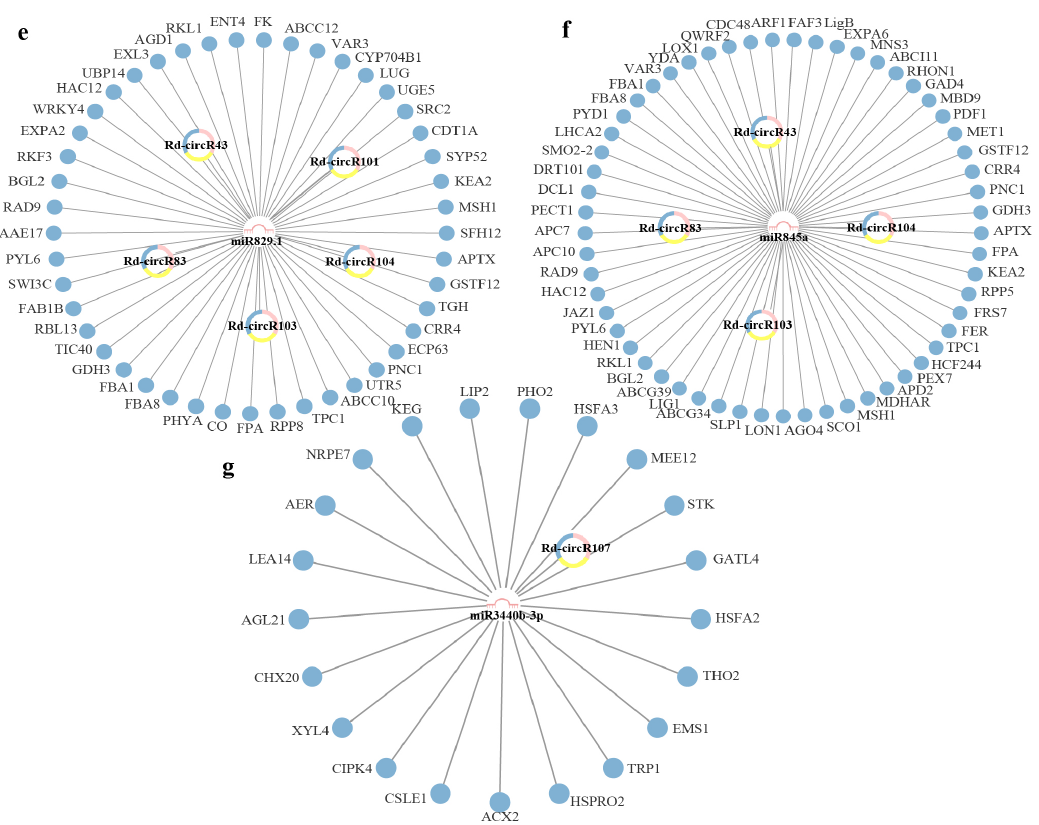
Figure 5. The prediction of circRNA-associated interaction networks during the lifespan of flowers: ( a – g ) the circRNA-miRNA- mRNA networks of all the identified